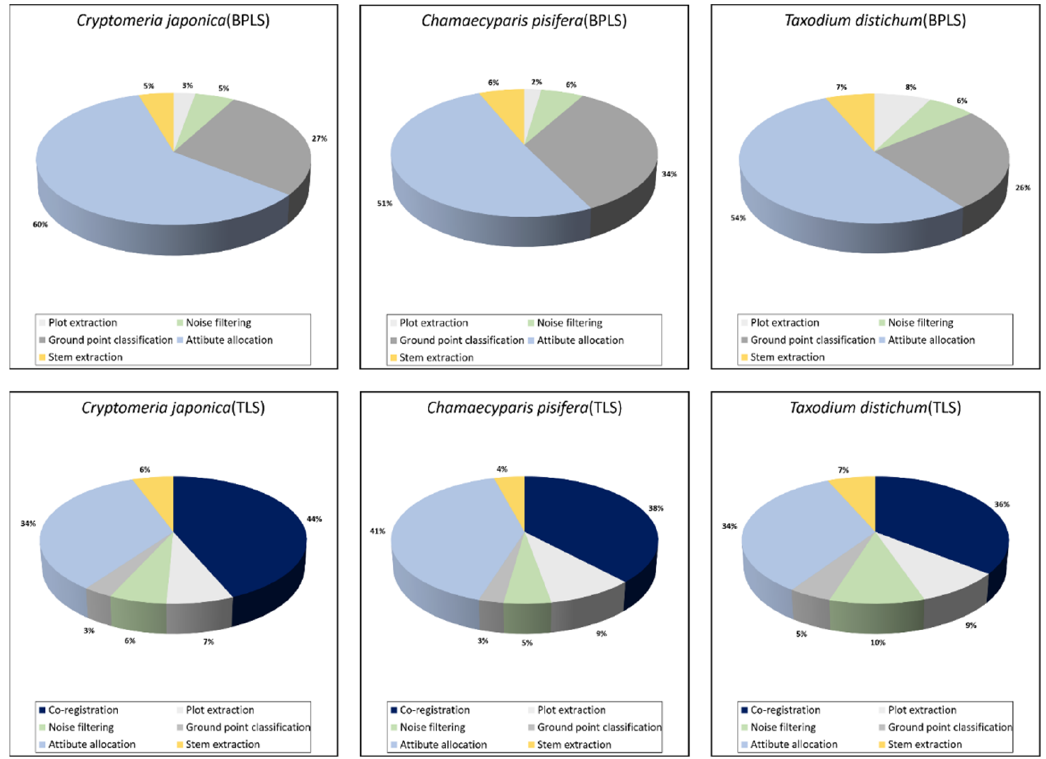
Figure 10. Comparison of the share of each internal task of the entire process by device and